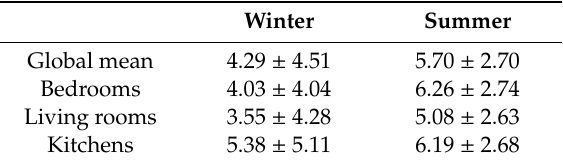
Table 3. Seasonal dust loadings (mean standard deviation) in dwelling of the district of Aveiro. Values are given in mg / m 2 / day.